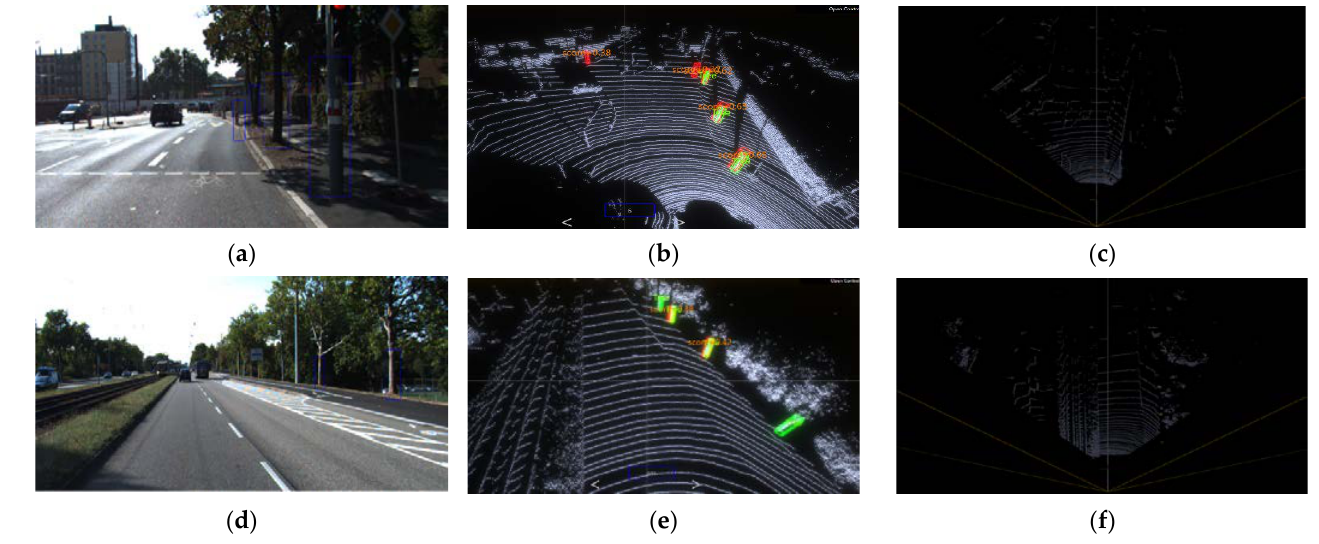
Figure 9. Test results of SECOND. ( a ) Camera image; ( b ) 3D view of the ( a ); ( c ) a bird’s eye view of ( a ); ( d ) camera image; ( e ) 3D view of ( d ); ( f ) a bird’s eye view of ( d